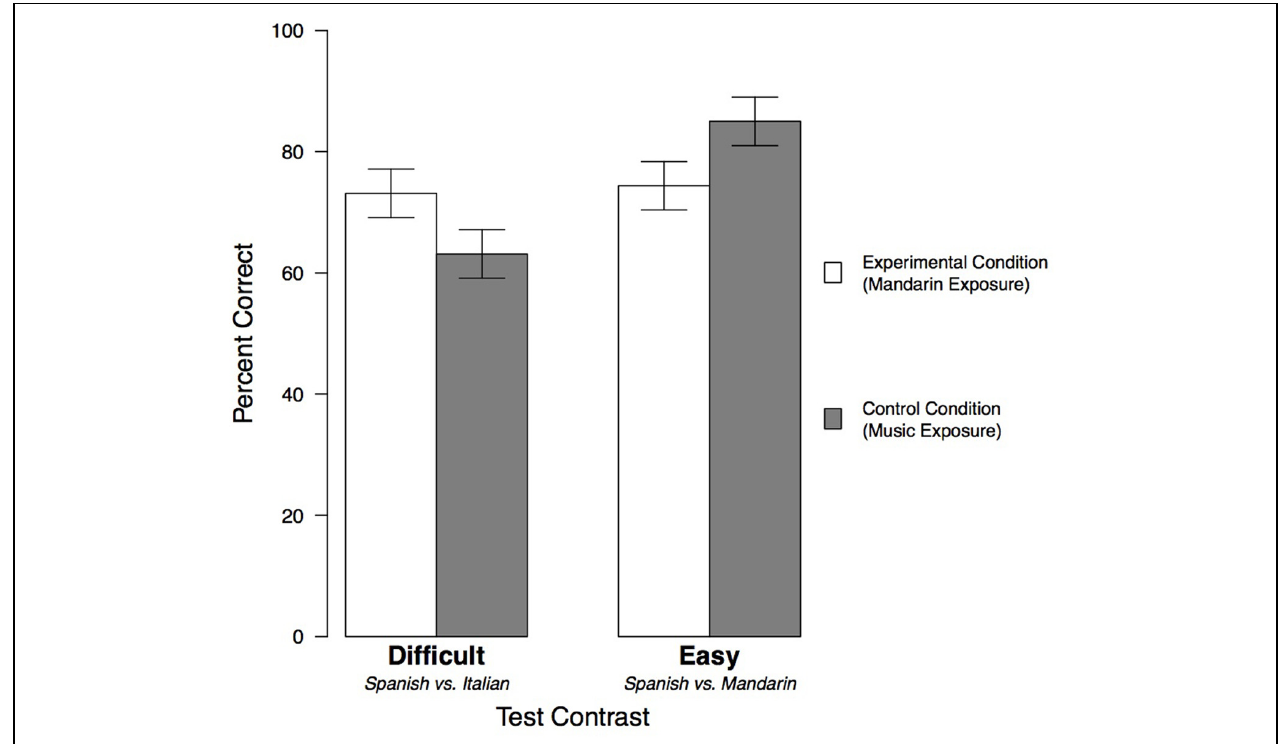
FIGURE 2 | Children’s performance in Experiment 1, divided by Test contrast and Exposure Condition. Error bars indicate standard errors.